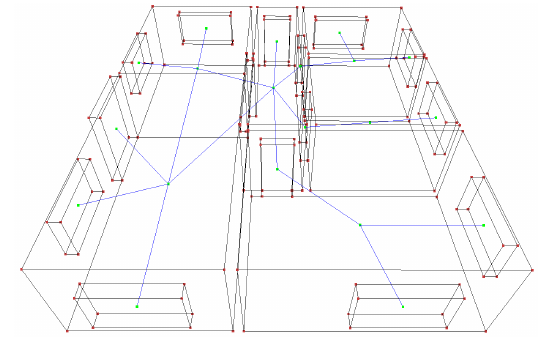
Figure 7. IndoorGML core module extracted from the LCC. The red vertices and black edges are those of the CellSpaces (primal space), while the green Nodes and the blue Edges are the corresponding network (dual